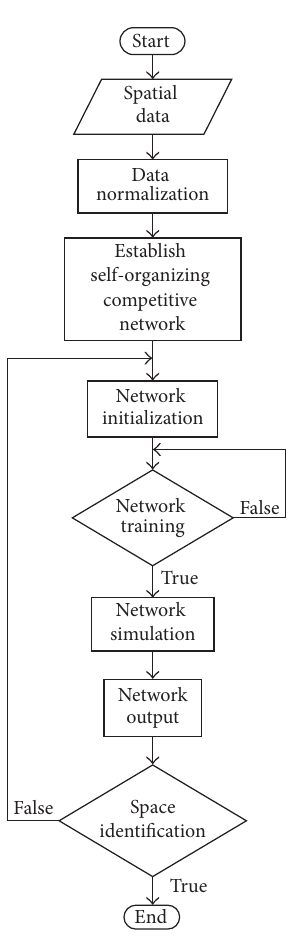
Figure 2: Flowchart of space identification